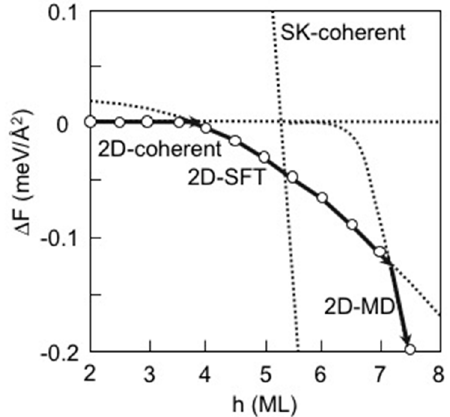
Figure 6. Calculated free energy differences ∆ F for various growth modes for the InAs/GaAs(111)A as a function of layer thickness h .